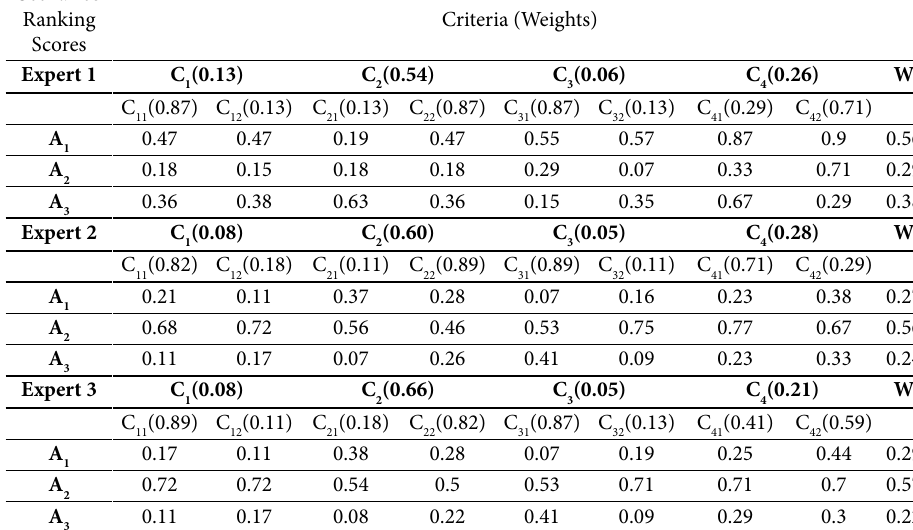
Table 7. Ranking scores with respect to each